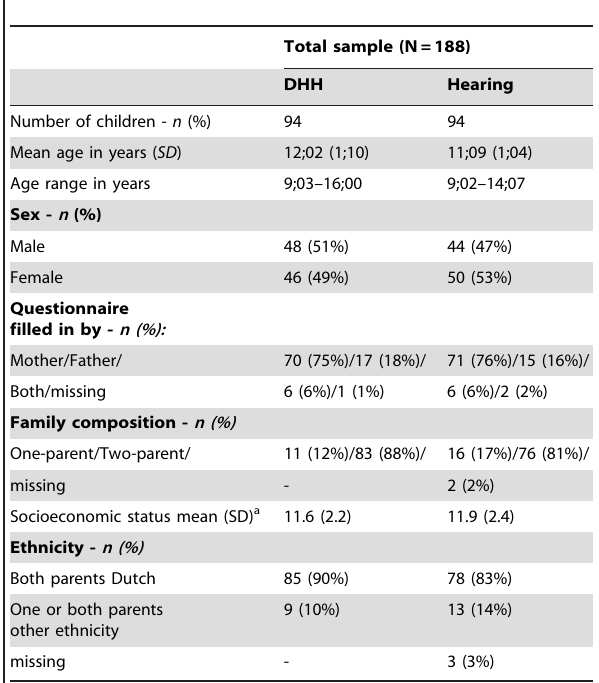
Table 1. Characteristics of Participants.